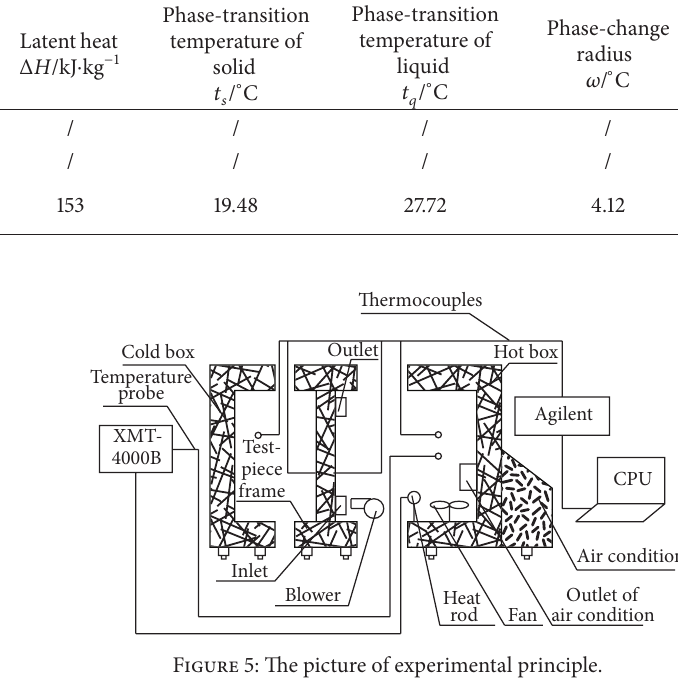
Figure 3: The picture of the actual object of JW-I.